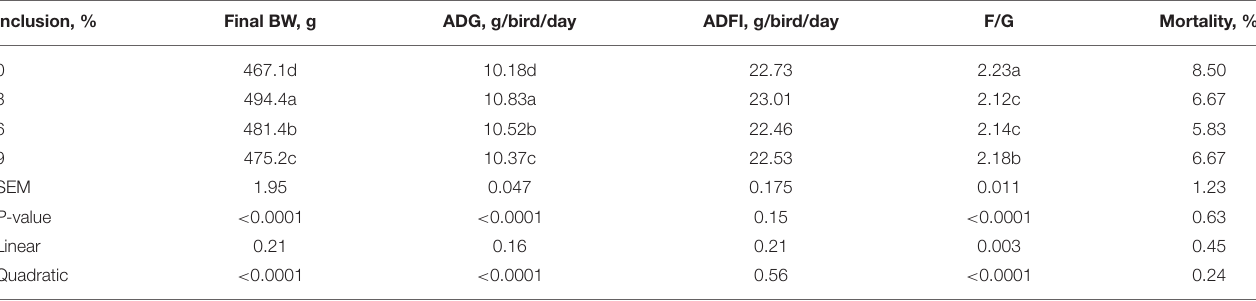
TABLE 2 | Effect of dietary low-inclusion levels of full-fatted black soldier fly larvae meal on the growth performance of layer chickens during 1–42 days of age (each value represents the mean of six replicates). Inclusion, %